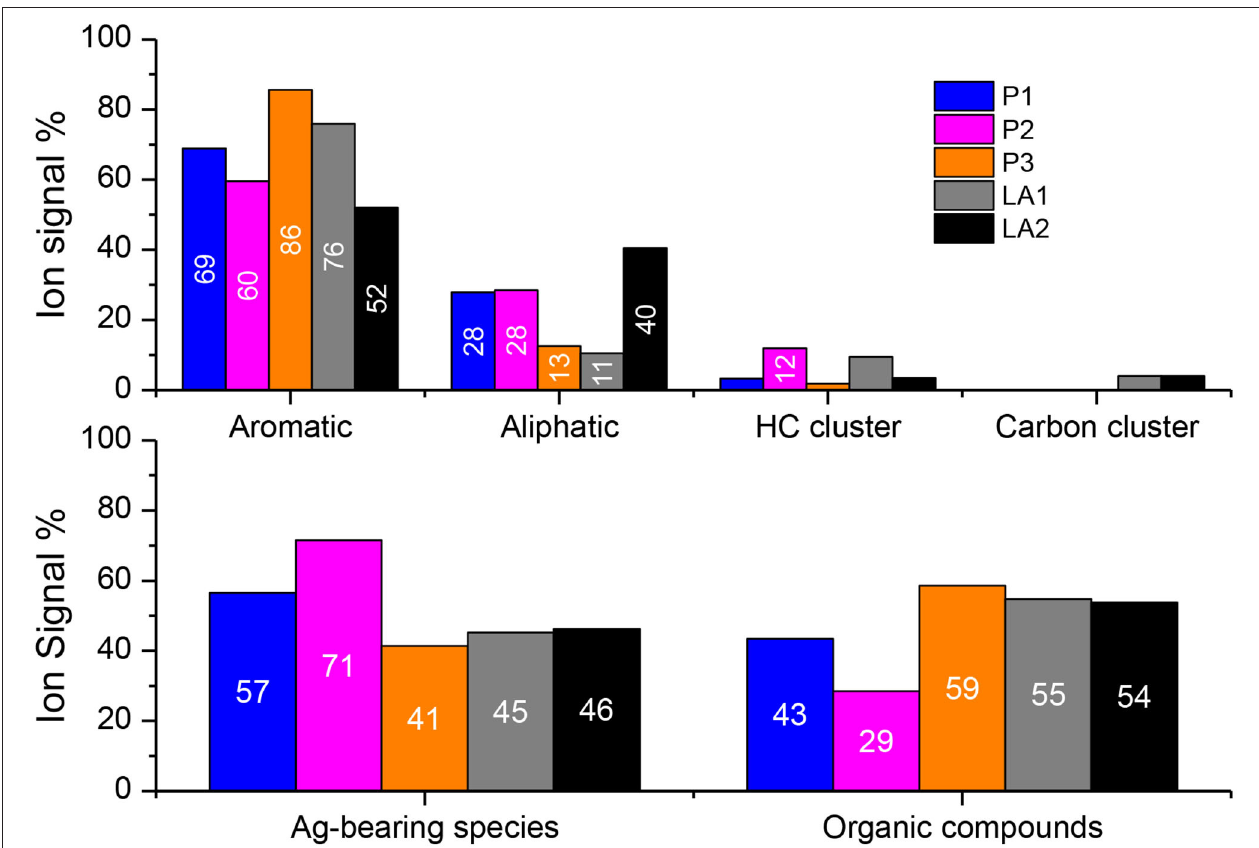
FIGURE 6 | Molecular family analysis of the different samples, P1, P2, P3, LA1, LA2 (see Table 1 ) analyzed with AROMA. The bottom diagram shows the fraction of summed ion intensities of Ag-bearing compounds relative to organic compounds. The top diagram separates the organic compounds (C x H y O 0,1 species) into the families defined in Figure 5 and section